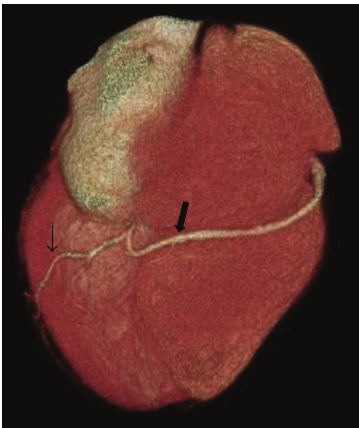
Figure 2: Inferior view of three-dimensional computed tomogra- phy scan shows superdominant right coronary artery (large arrow) to supply posterior wall (small arrow).